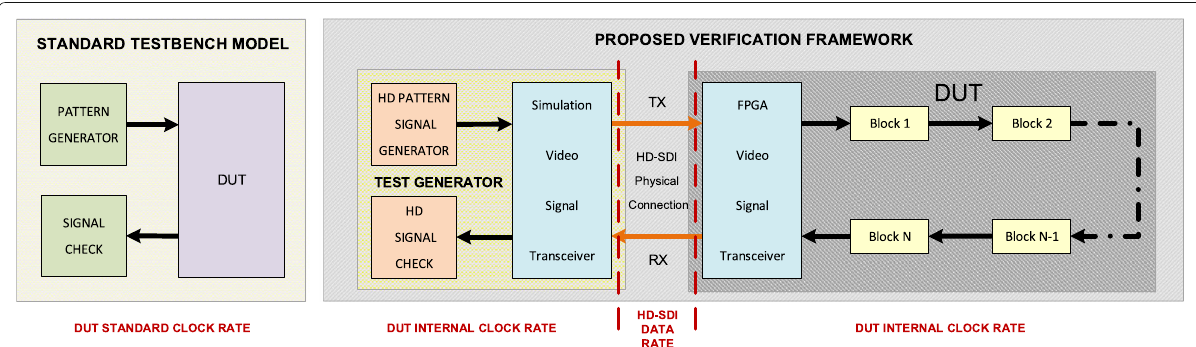
Fig. 3 (Left) Standard test-bench model. (Right) Video test-bench framework with double transceiver system for SDI simulation. Blocks 1 to N represent the video processing chain